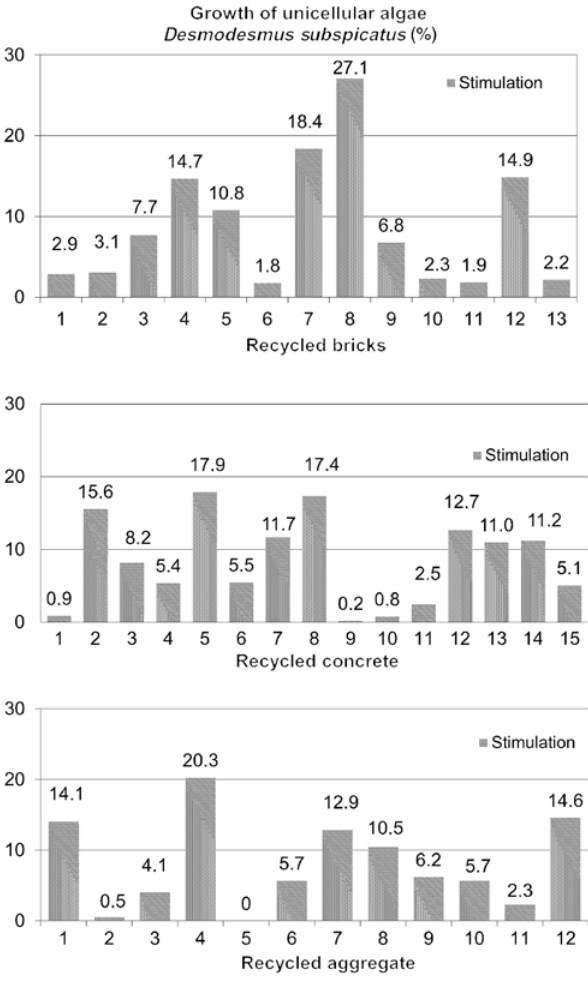
Figure 5: Stimulation of the growth of D. subspicatus unicellular